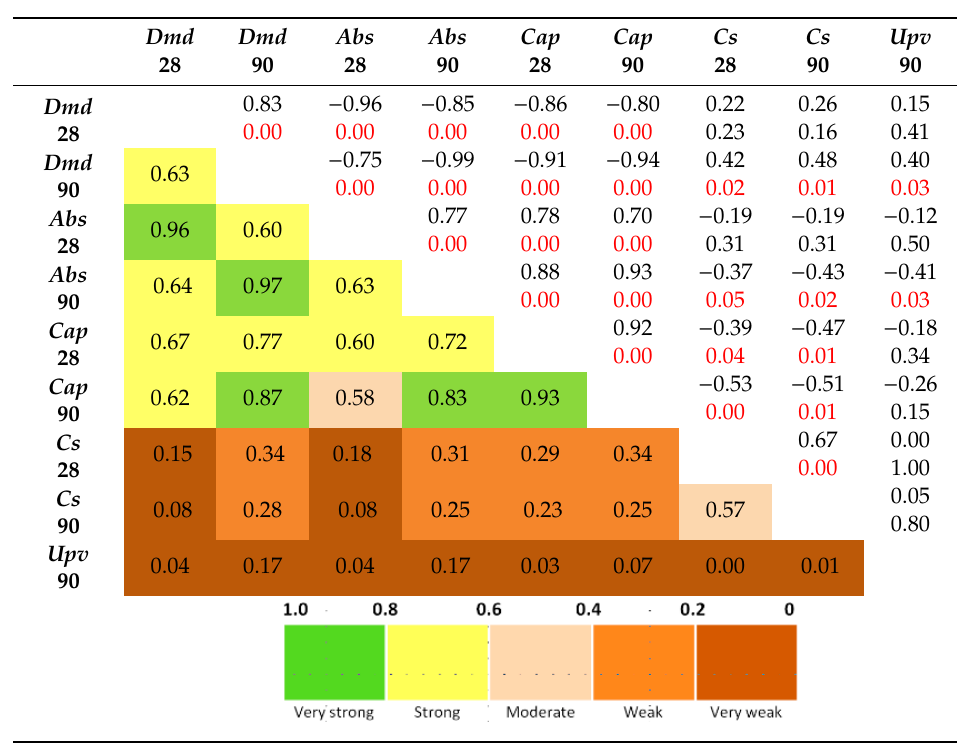
Table 8. Matrix of linear correlations of the series, including all the representative specimens of each sample with 28 and 90 days of curing time. On the diagonal, in each cell, the upper value indicates the Spearman correlation between variables, and the lower p -value of the Anova analysis; under the diagonal, the cell indicates the R 2 coefficient coloured according to Evans scale [41].